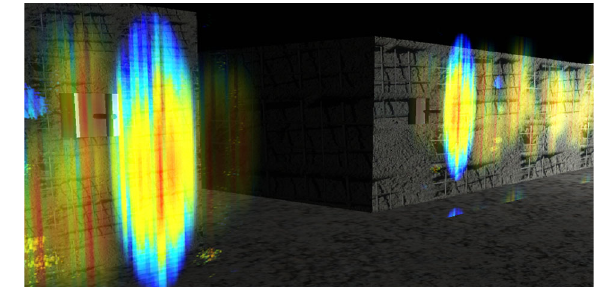
Fig. 17 Maximum amplitude echo points with KF and MA filters